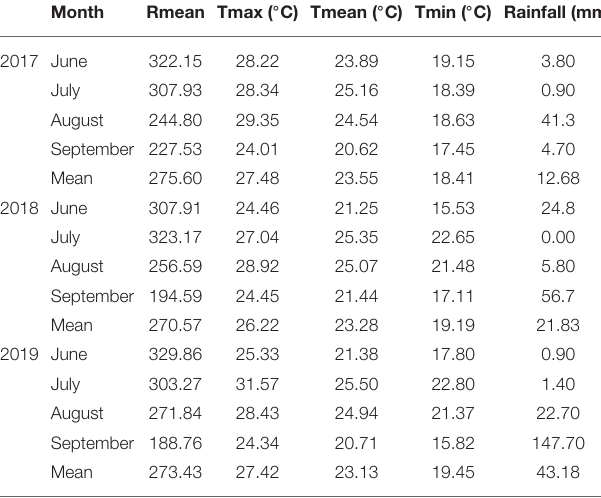
Frontiers in Nutrition |